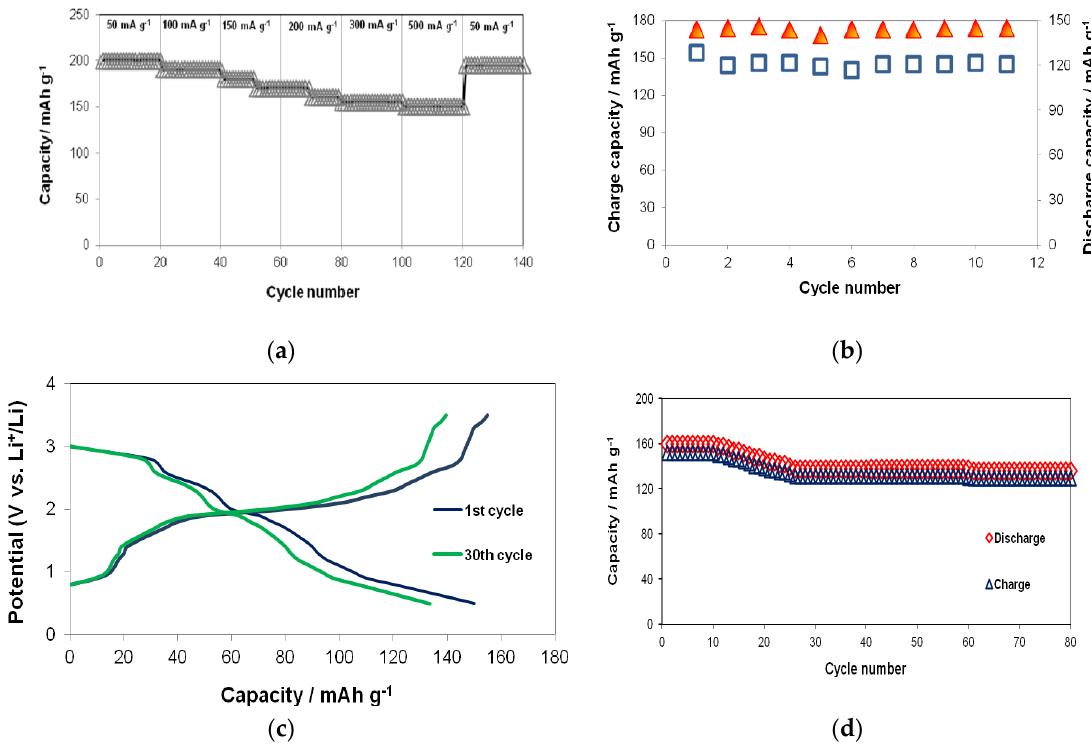
Figure 7. Rate performance under various current densities of S 2 V 1 Ti 1 /Li ( a ); the cycling performance of the Li/LiFePO 4 system at C/5 ( b ); the charging/discharging curves of the full cell at 3C (S 2 V 1 Ti 1 anode and LiFePO 4 cathode) ( c ); cyling performance of the full cell at 3C.